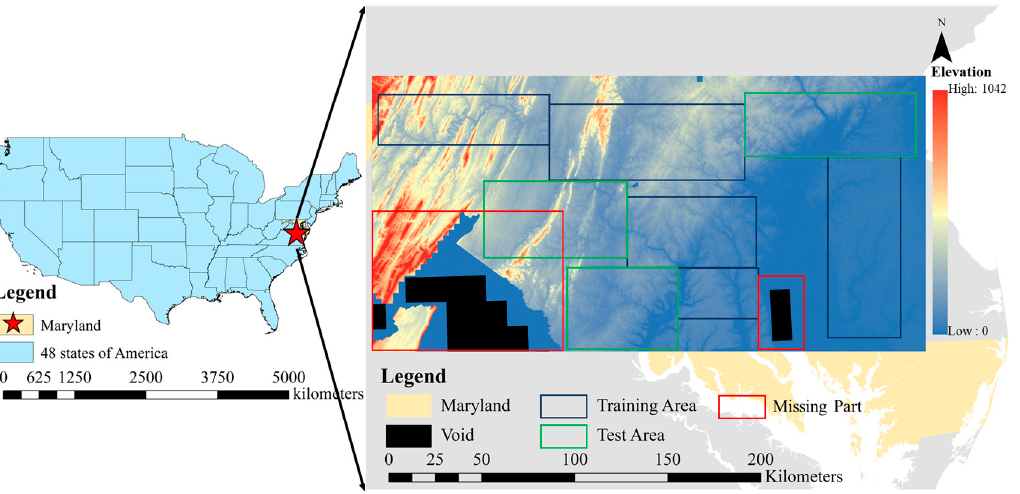
Figure 6. Location of the DEM data in the Maryland study area used for training, validation, and testing.